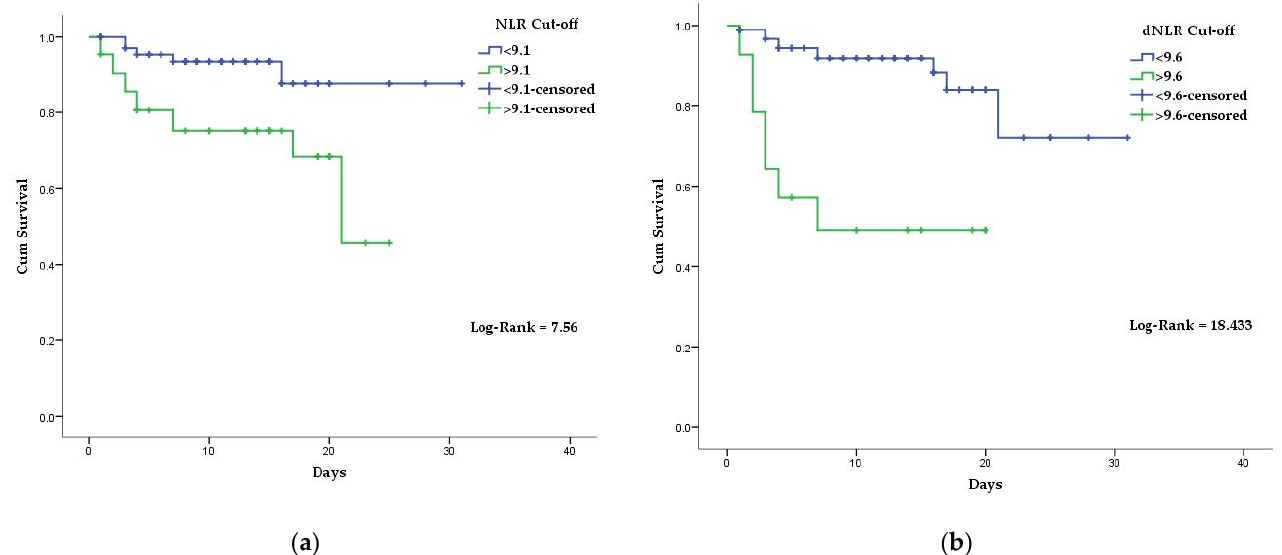
Figure 2. Kaplan–Meier survival curves of hospitalized COVID-19 patients: ( a ) according to estab- lished NLR cutoff values; ( b ) according to established dNLR cutoff values.